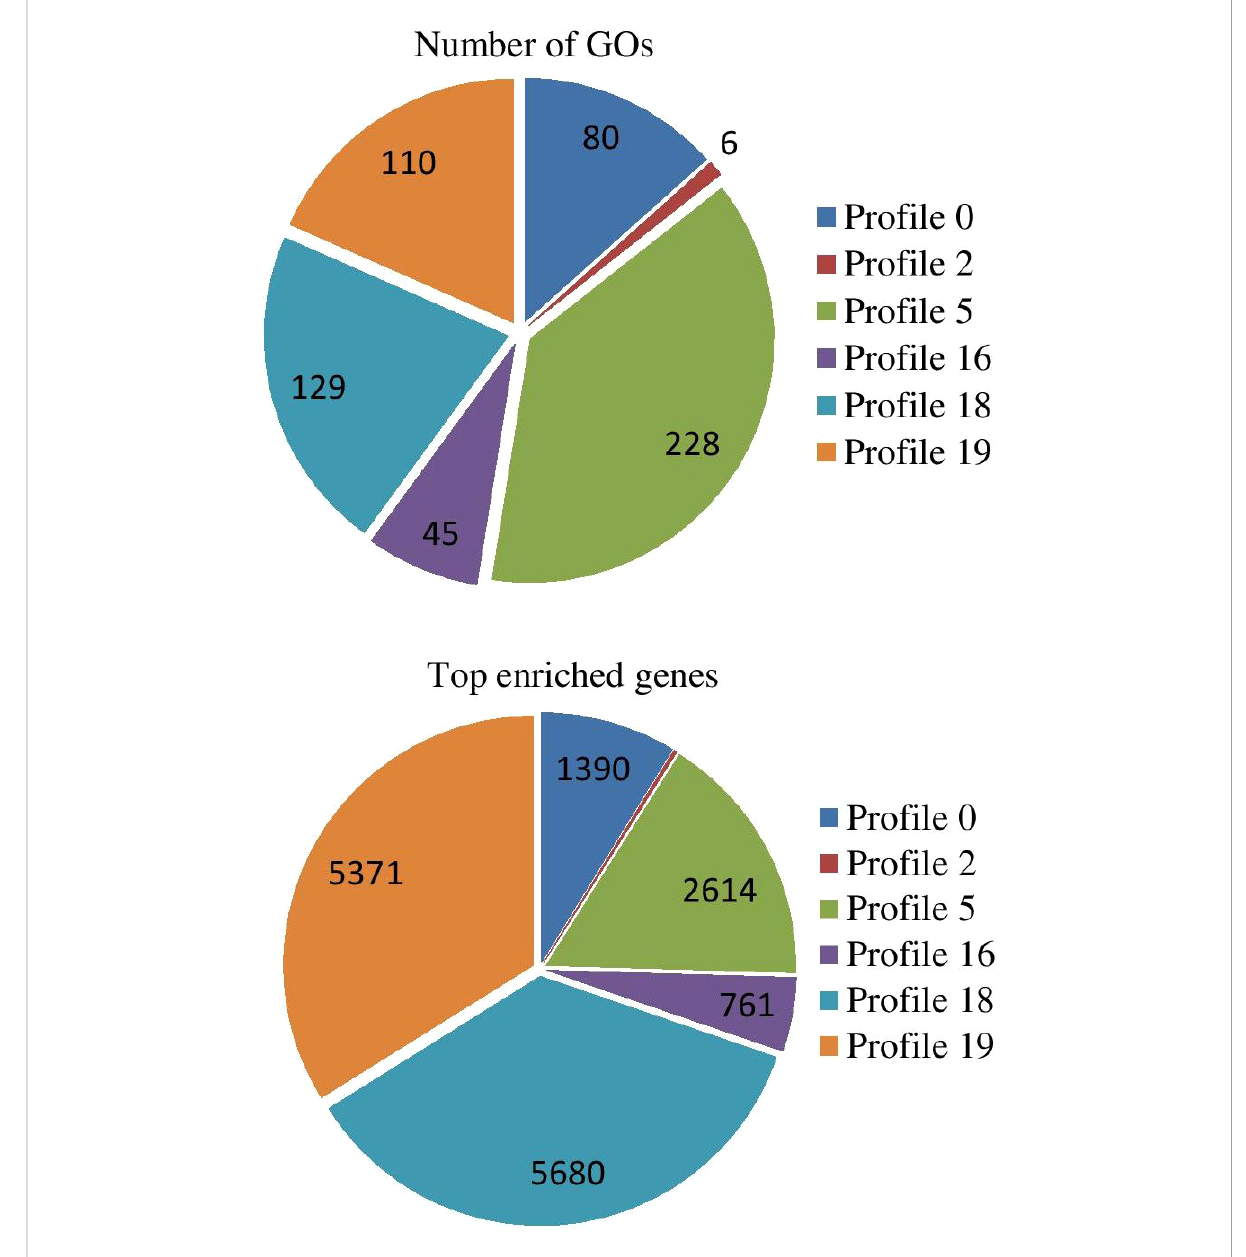
FIGURE 10 Signi fi cant GO enrichment analyses of top enriched genes in different